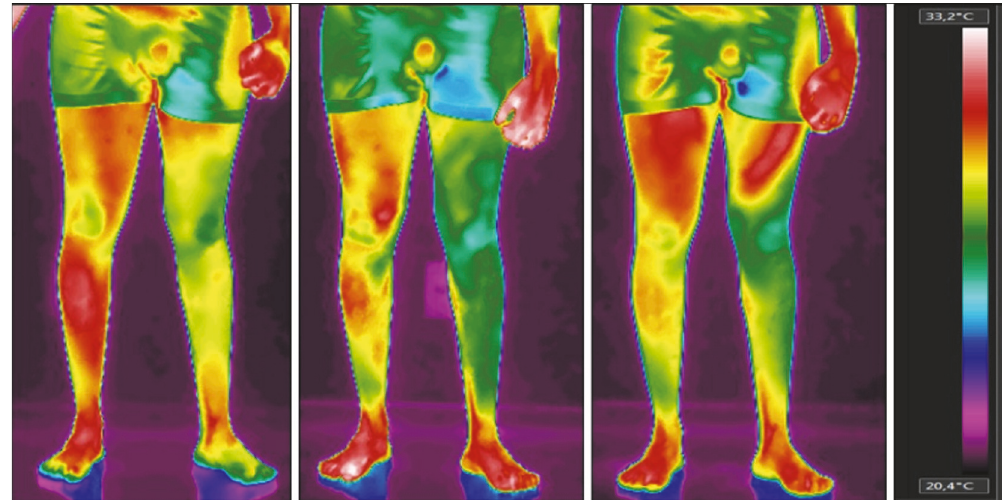
Figure 1: Thermographic image of the anterior regions of thigh and lower leg at baseline, immediately after the robotic training, and 30 minutes after the end of the robotic training (from left to right).